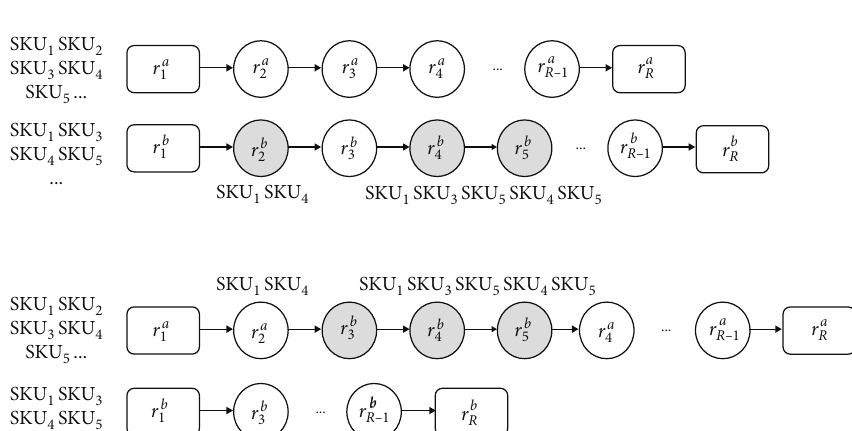
Figure 6: Station-remove operator.